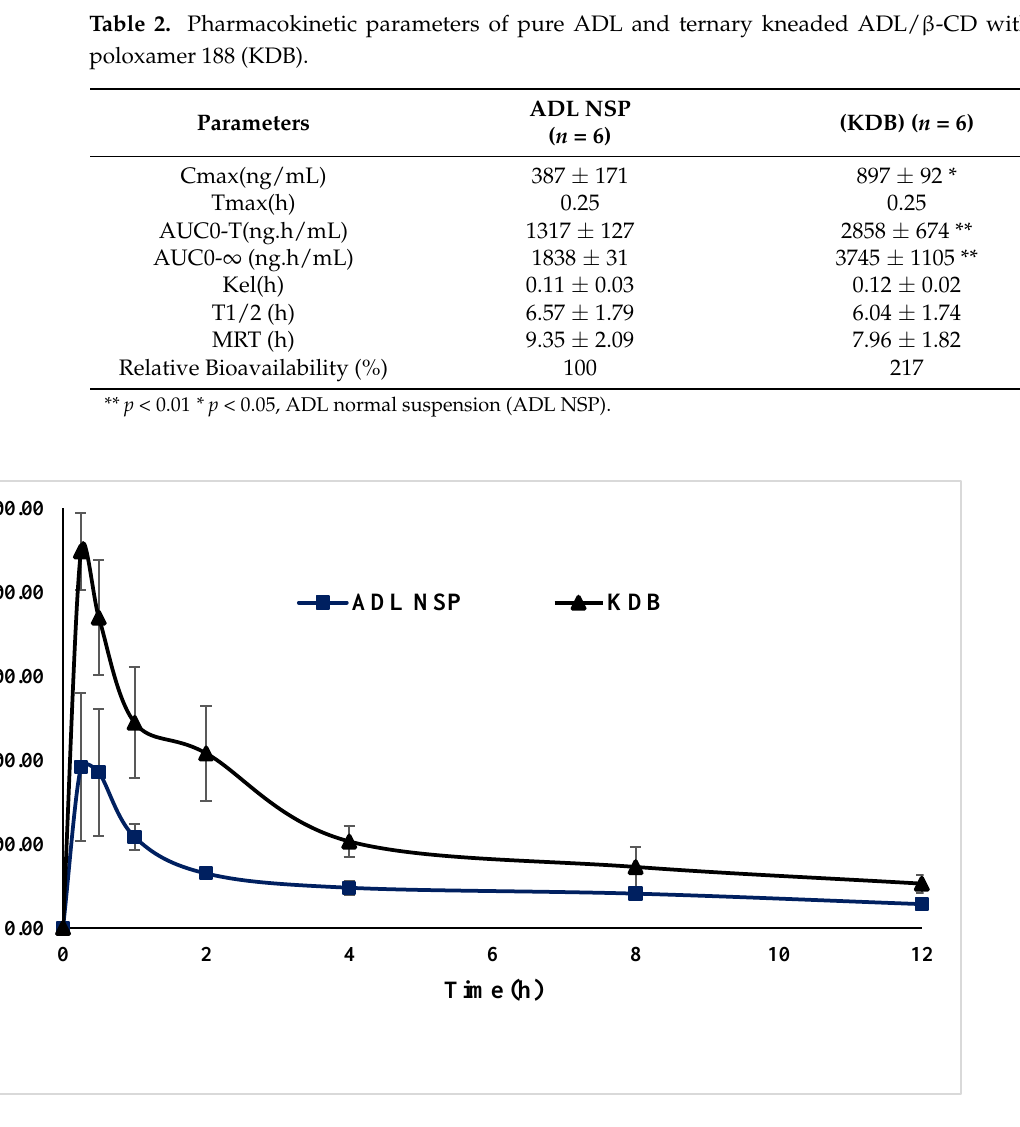
Figure 9. Plasma concertation time profile of the ADL normal suspension (ADL NSP) and ternary kneaded ADL/β-CD with 1% poloxamer 188 (KDB) after the oral administration of 20 mg/kg in rats ( n = 6 each).